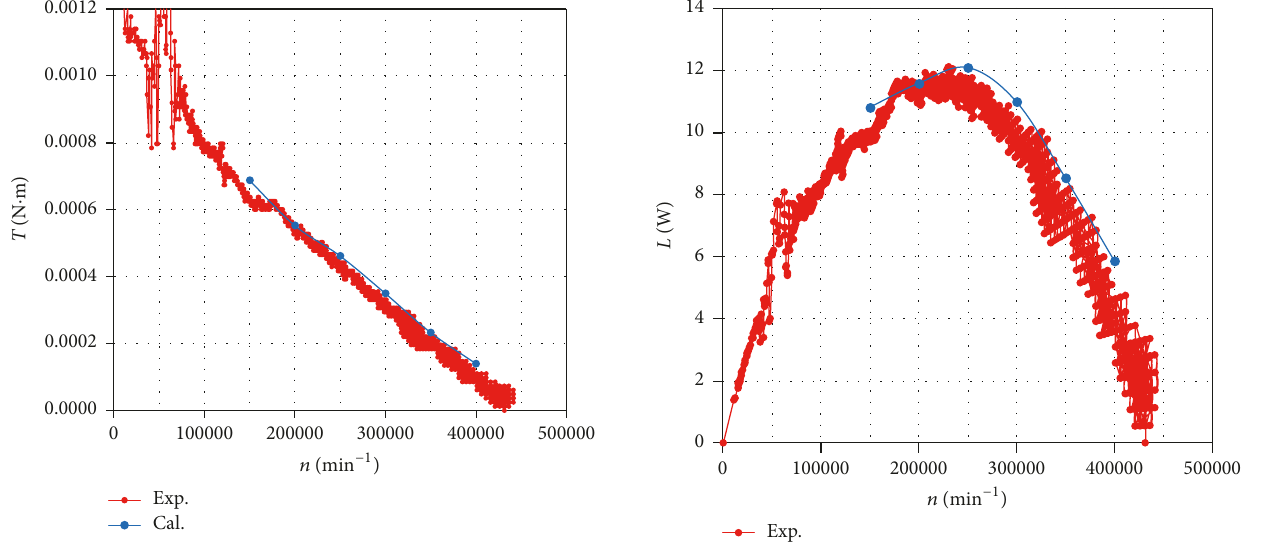
Figure 9: Correlation between rotational speed and torque.